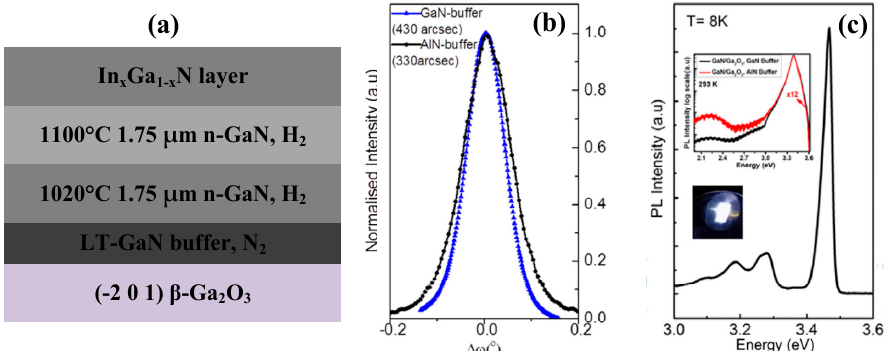
Figure 10. ( a ) Structural diagram of GaN on β -Ga 2 O 3 via atmosphere switch and two-step growth. ( b ) The XRC of GaN (0 0 0 2) reflection peak for GaN grown on ( − 2 0 1) β -Ga 2 O 3 substrate with GaN buffer layer and AlN buffer layer. ( c ) PL spectra of GaN grown on ( − 2 0 1) β -Ga 2 O 3 substrate with a GaN buffer layer at 8 K. Reprinted with permission from Reference [103]. Copyright 2016 Springer Nature.